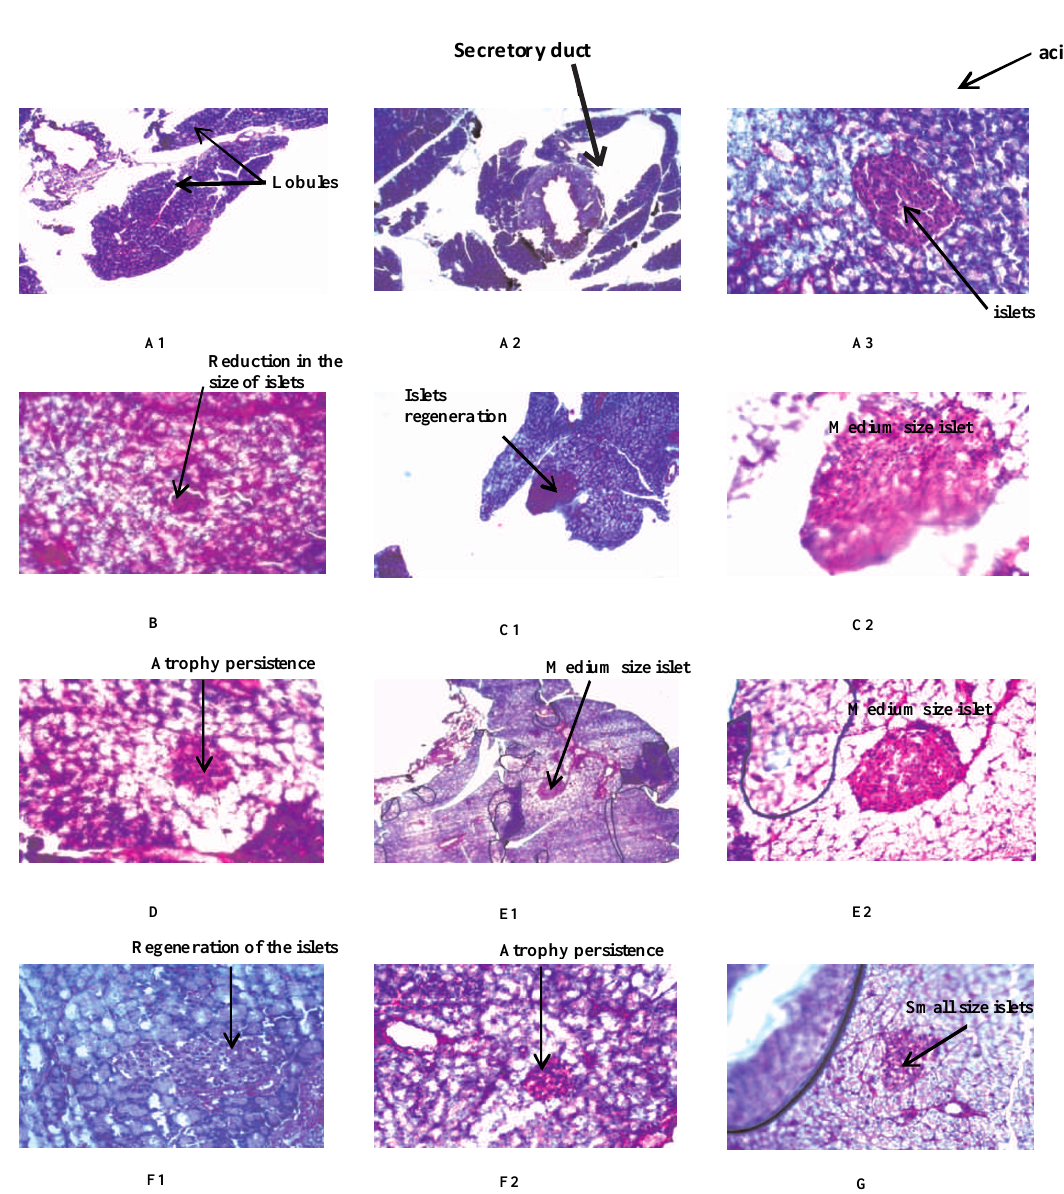
Figure 2. Effect on Nigella sativa extract on pancreatic tissue, Histology of pancreatic tissues from normal rats (A1, A2 & A3), untreated diabetic rats (B); diabetic rats treated (for 17 days) with total Nigella sativa seeds oil at100mg/kg bw/day (C1&C2), lipid polar (D) and neutral (E1&E2) fractions from total Nigella sativa seeds oil at100mg/kg bw/day; thymoquinone at 25 mg/kg bw/day (F1&F2) and metformin at 25 mg/kg bw/day (G). Diabetes was induced by N/STZ. Magnification: x125 for A1, C1, E1 and x425 for the others. Slides are stained with haematoxylin and eosin